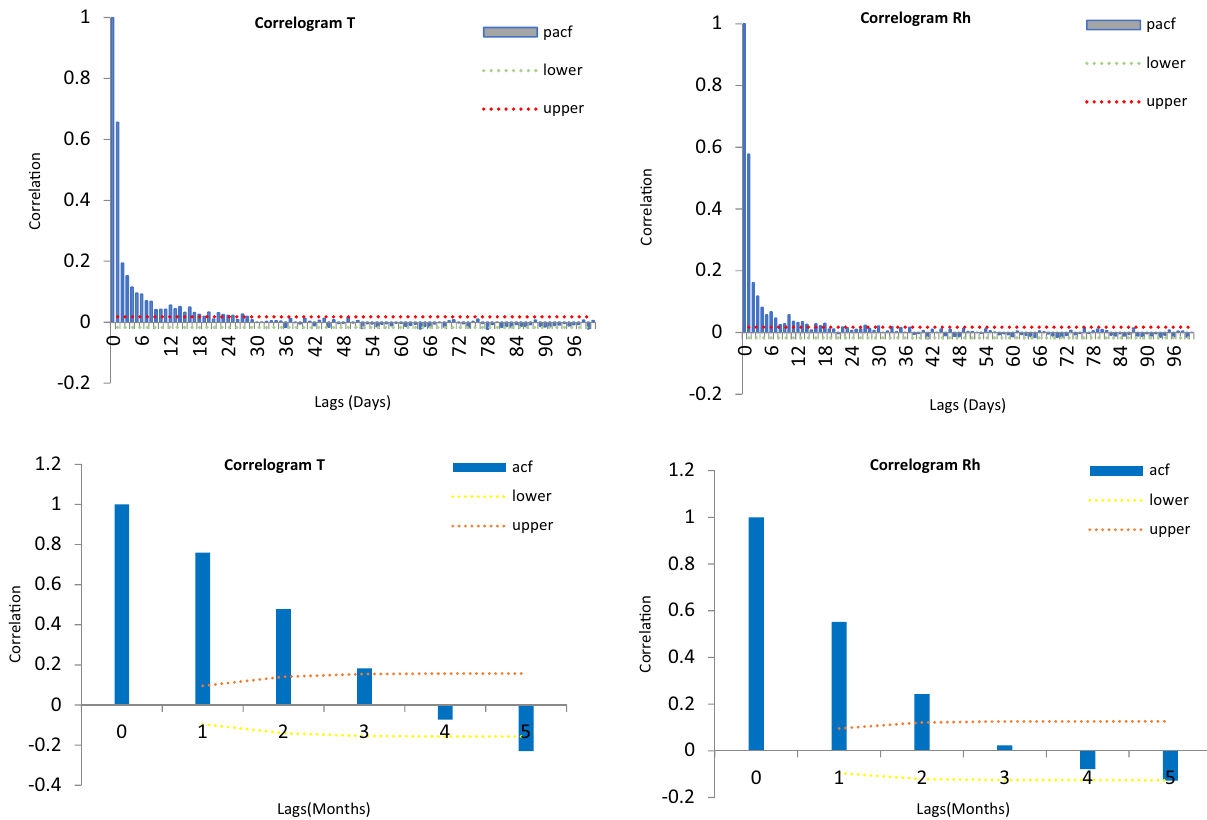
Figure 6. A.C.F. and PACF for air temperature and relative humidity using daily and monthly